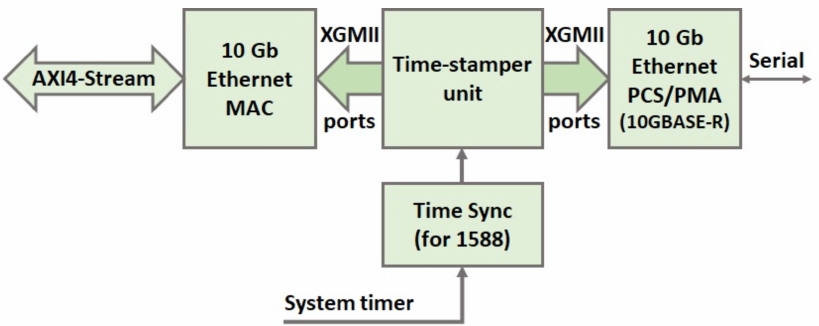
Figure 7. Proposed subsystem for synchronisation. AXI4: advanced eXtensible interface 4, MAC: medium access control, PCS / PMA: physical coding sublayer / physical media attachment, XGMII: 10 gigabit media independent